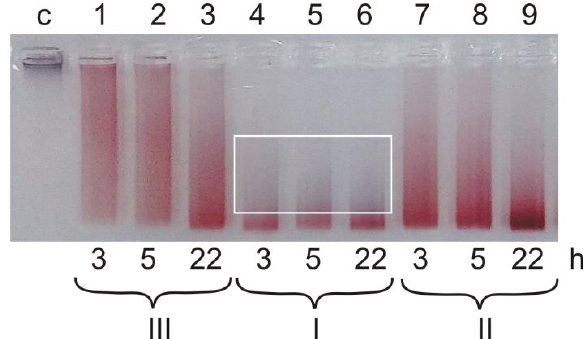
Figure 1. Agarose gel electrophoregram of the cores (non-covalent associates of siRNA and AuNPs), obtained by varying of component concentration and the incubation time. C, control (citrate AuNPs, not having electrophoretic mobility); I, II and III, samples of cores at different concentrations of initial components (Table 1). Incubation time is shown at the image bottom. Agglomeration area is shown by white rectangle.